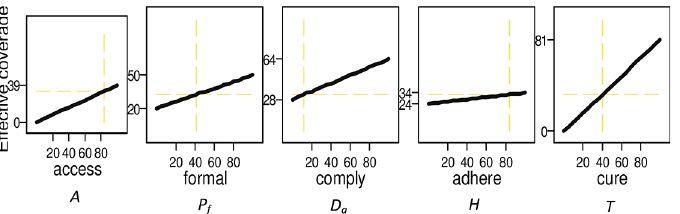
Fig 4. Impact of Service Parameters on Level of Effective Coverage: Nigeria. Labeled on the x-axis are: A Access to any care provider; Pf Access to a formal care provider; Da Compliance with the first-line antimalarial treatment; H Adherence; T Cure rate. Effective coverage. E, evaluated by varying each of the service indicators from 0 to 100% while holding all other inputs at base value. Values of effective coverage at lowest and highest values of inputs are labeled on the y-axis to illustrate the sensitivity. Baseline values of inputs and effective coverage are shown in dash